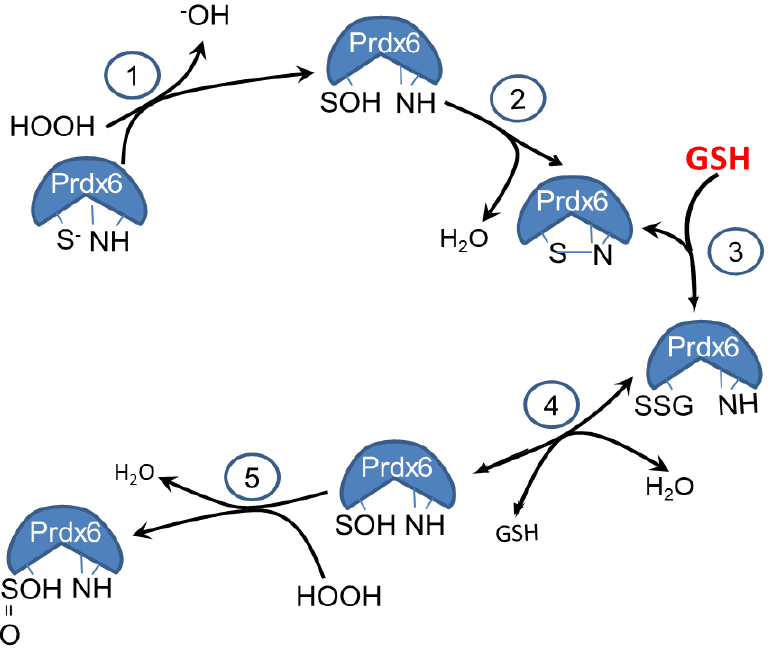
Figure 5. Reactions of Prdx6 with GSH in vitro . Reactions 1 and 2 occur during isolation of Prdx6 in the absence of GSH and GST; auto-oxidation of the protein by oxidant generation (shown here as HOOH) in the presence of trace metals leads to the formation of the Prdx6 sulfenic acid (reaction 1) and then dehydration to form the sulfenylamide (reaction 2). Reaction 2 is rapid when compared to the relatively slow rate of H 2 O 2 formation (reaction 5 in the absence of GSH). Reactions 3 and 4 occur in vitro following the addition of GSH in the absence of GST. The sulfenylamide is reversed through glutathionylation of the protein (reaction 3), followed by reformation of the sulfenic acid (reaction 4). The rate of H 2 O 2 generation is greatly enhanced in the presence of GSH [34], resulting in the oxidation of the sulfenic to the sulfinic (reaction 5 in the presence of